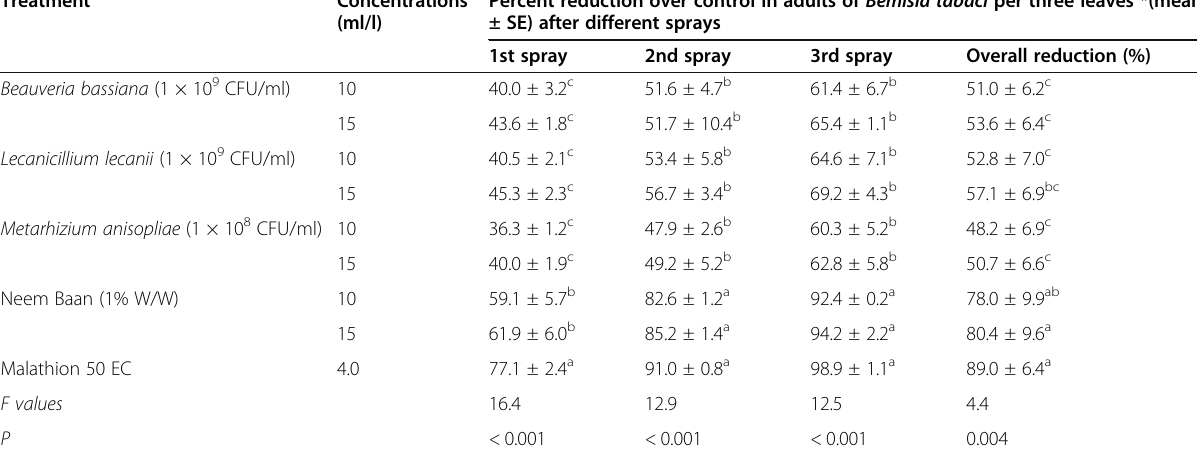
Table 7 Efficacy of different biopesticides against adults of Bemisia tabaci on cucumber under net house conditions during autumn cropping season (2018) Treatment